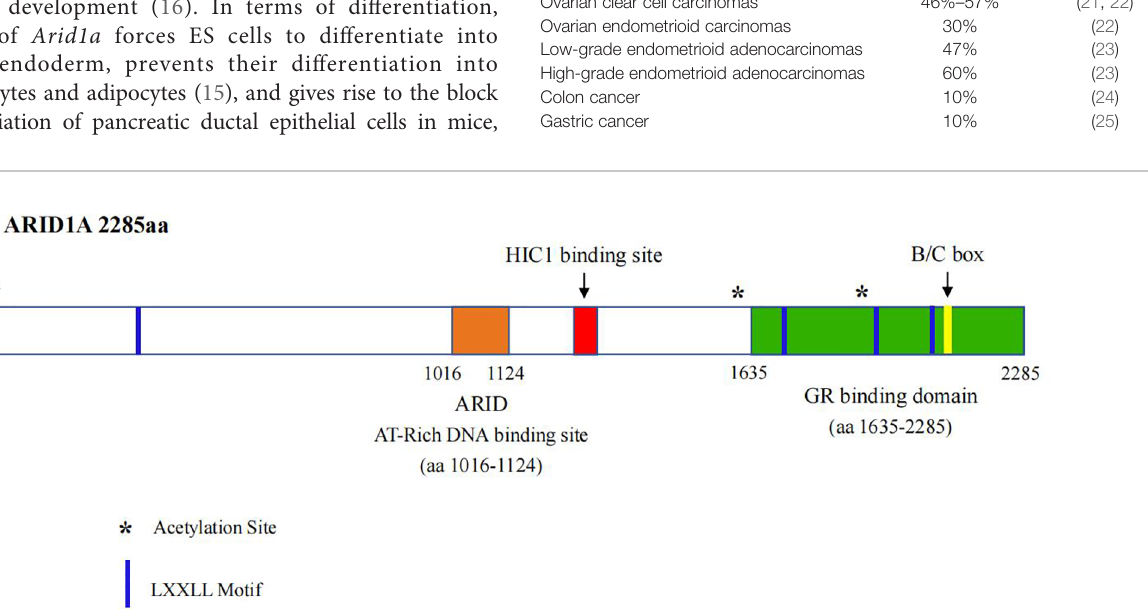
FIGURE 1 | Schematic representation of ARID1A protien structure.